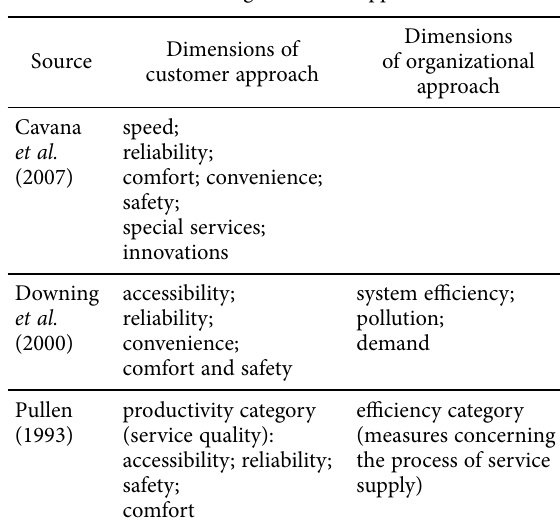
Table 1. Public transport services: customer-organizational